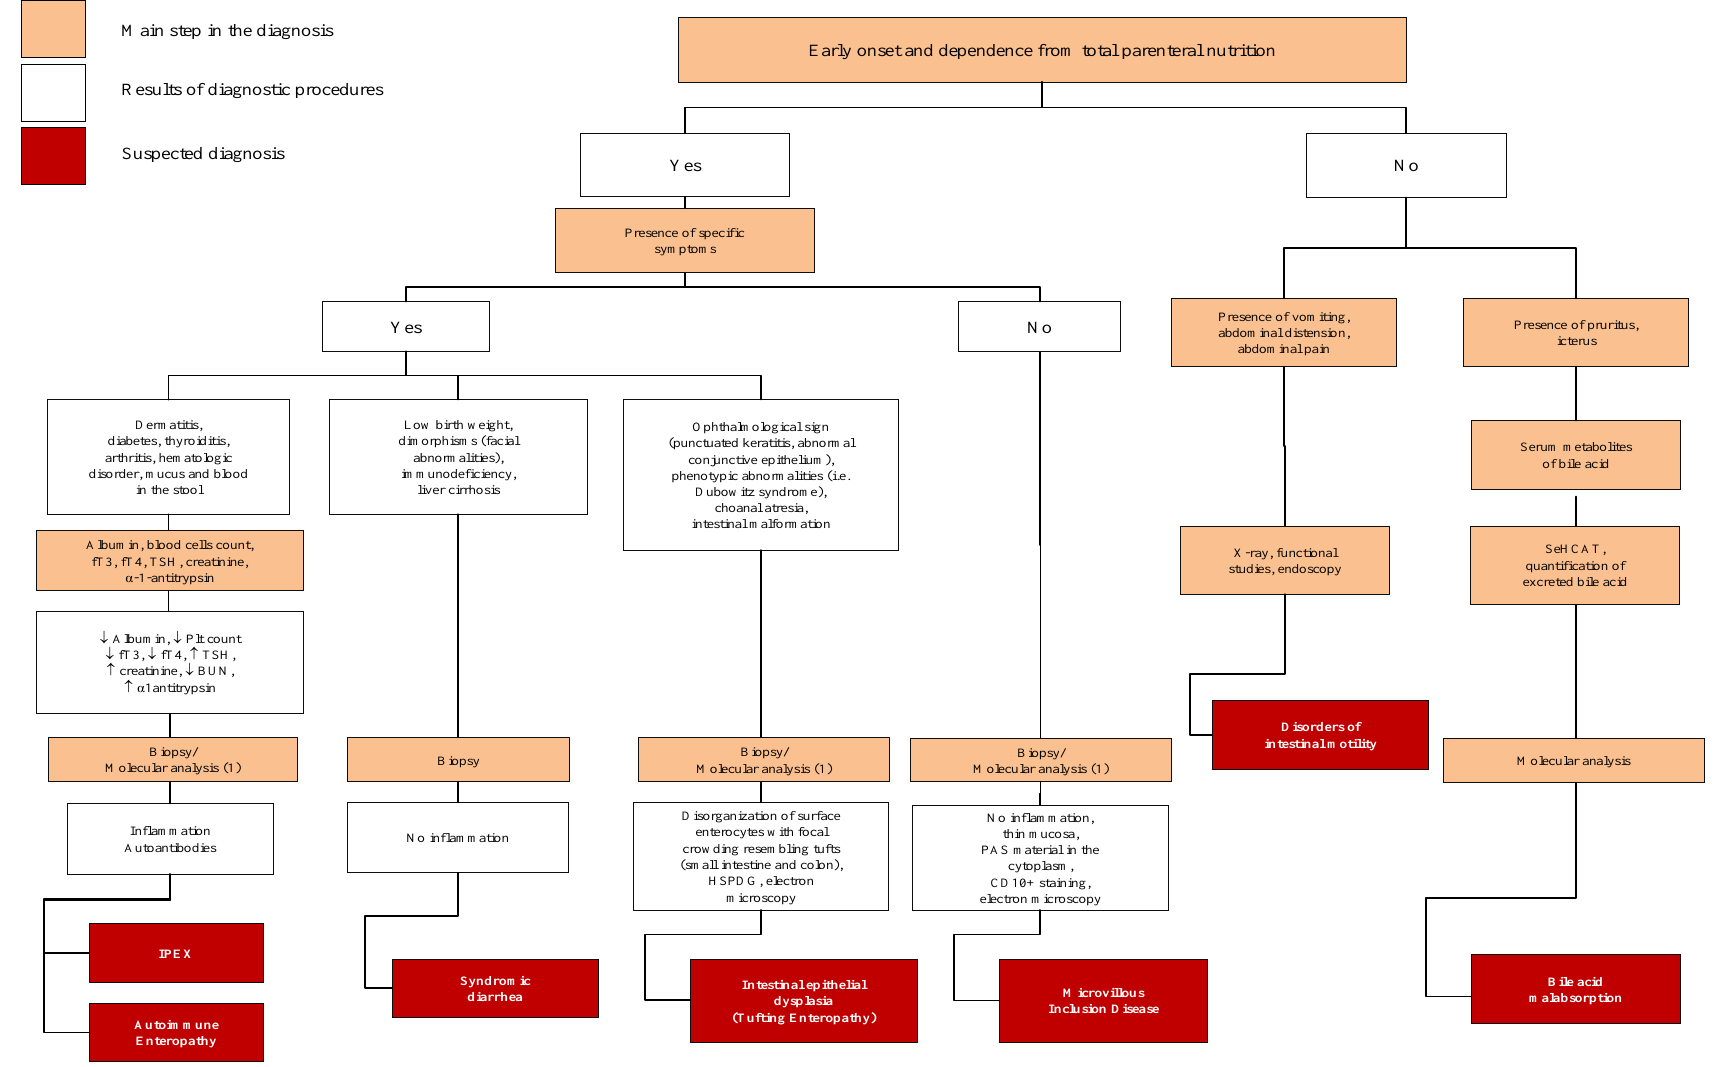
Figure 3. Diagnostic diagram of congenital diarrheal disorders determined by a secretory mechanism.